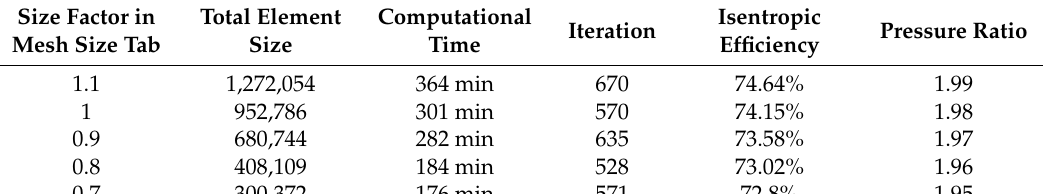
Table 3. Mesh-Independency and computational time.